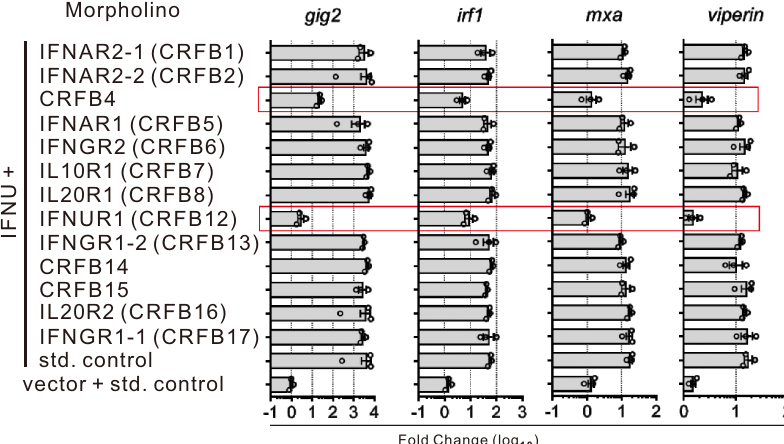
Fig. 3 Effects on zebra fi sh IFN- υ -induced ISG expression by knockdown of CRFB morpholinos. IFN- υ expressing plasmid and different morpholinos were co-injected into zebra fi sh embryos ( n = 500) at one-cell stage and 48 h later the expression of ISGs was detected by quantitative RT-PCR. The expression of the selected genes was normalized against gapdh and fold changes were calculated relative to control group which was co-injected in embryos ( n = 150) with empty plasmid (i.e., vector) and standard (std) control